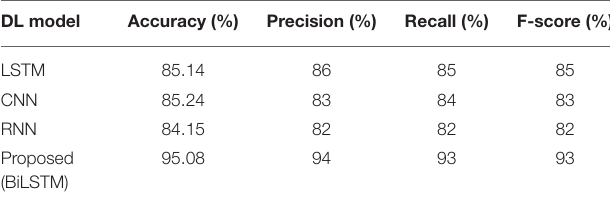
TABLE 4 | BiLSTM in comparison to other deep learning